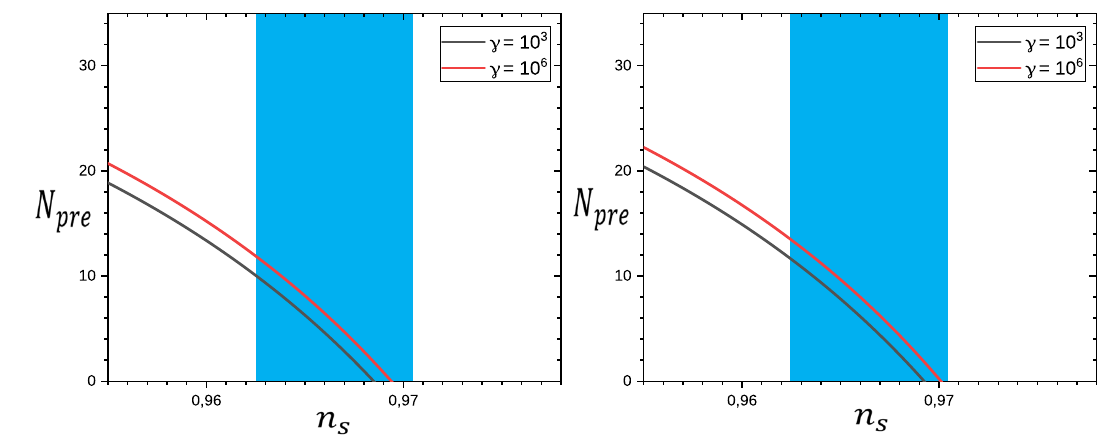
Fig. 3 The preheating N pre as functions of n s for chaotic inflation. We choose γ to be γ = 10 3 and γ = 10 6 . The blue region represents Planck’s bound on n s . In the left panel, we considered the temperature T re = 10 12 GeV , while in the right one, we choose a minimal reheating temperature T re =